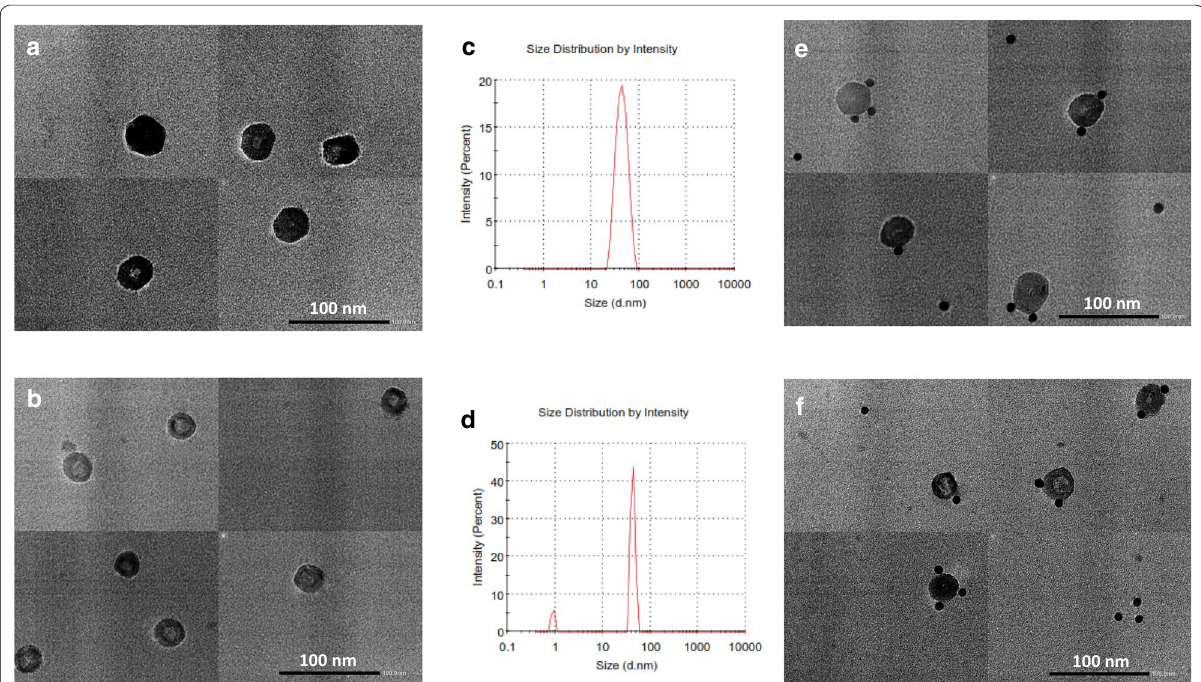
Fig. 4 TEM analysis of purified 3CprME ( a ) and 3prME ( b ) polypeptides. The purified 3CprME ( c ) and 3prME ( d ) polypeptides were